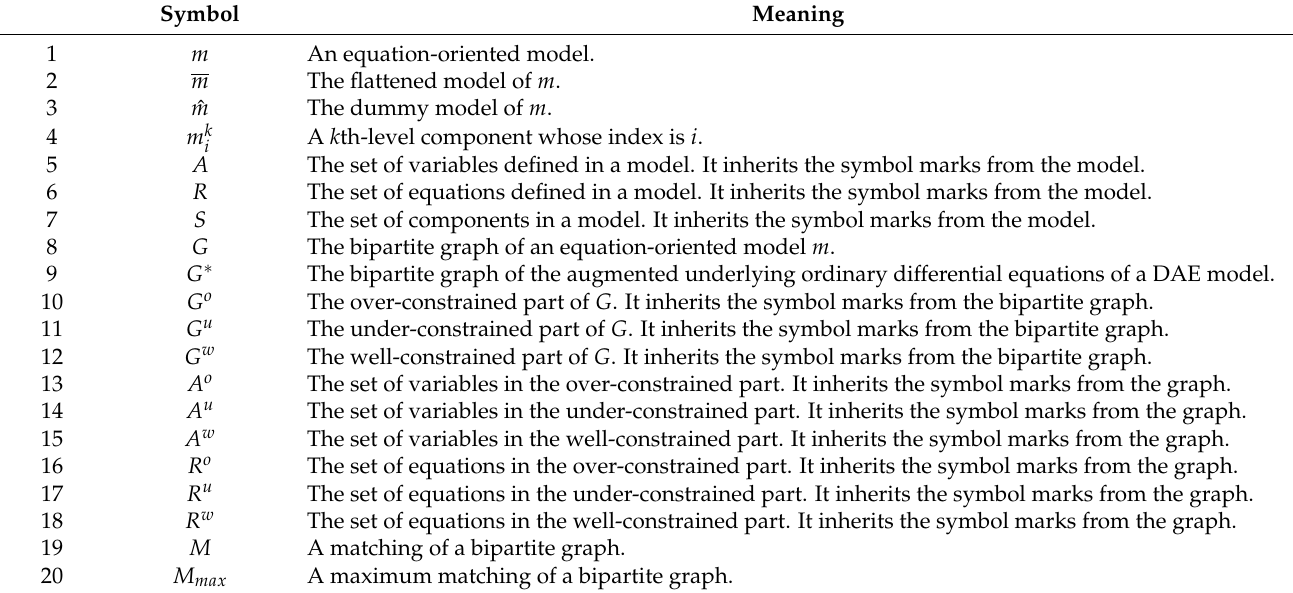
Table 1. The list of